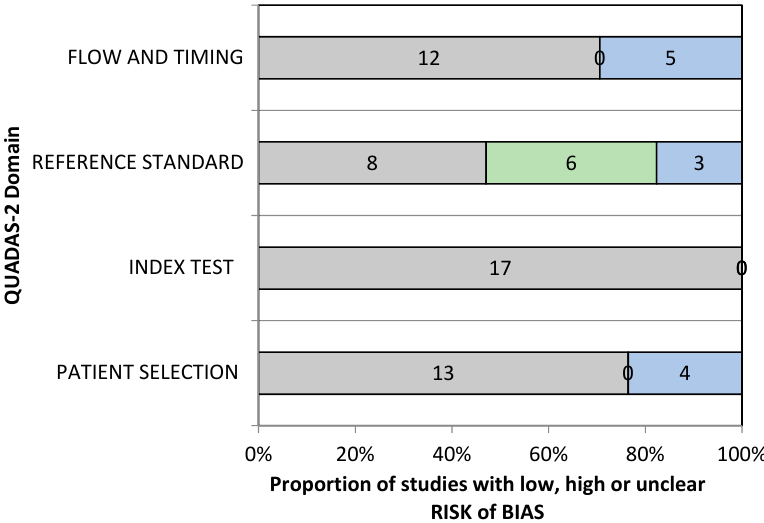
Figure 2. QUADAS-2 assessment of the individual risk of bias domains.